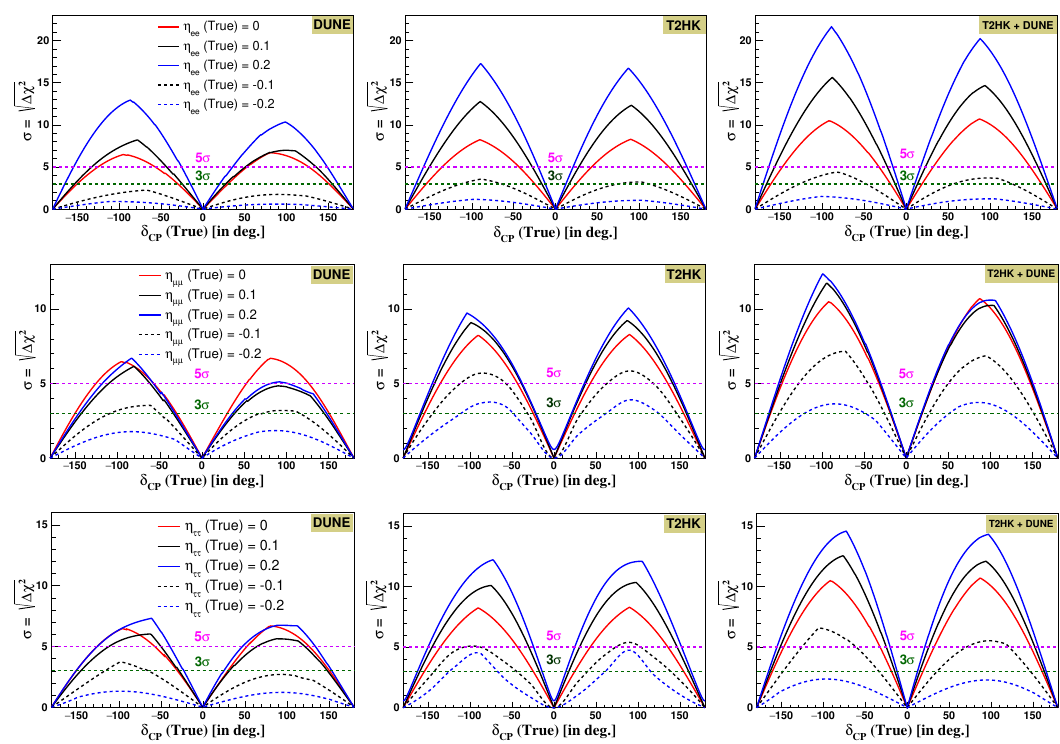
Figure 7 . The CPV sensitivity of DUNE (left-column), T2HK (middle-column) and DUNE + T2HK (right-column) in presence of scalar NSI. The plots for η top-row, middle-row and bottom-row respectively. The solid-red curve is for the no scalar NSI case whereas solid (dashed) black and blue curves are for positive (negative) η